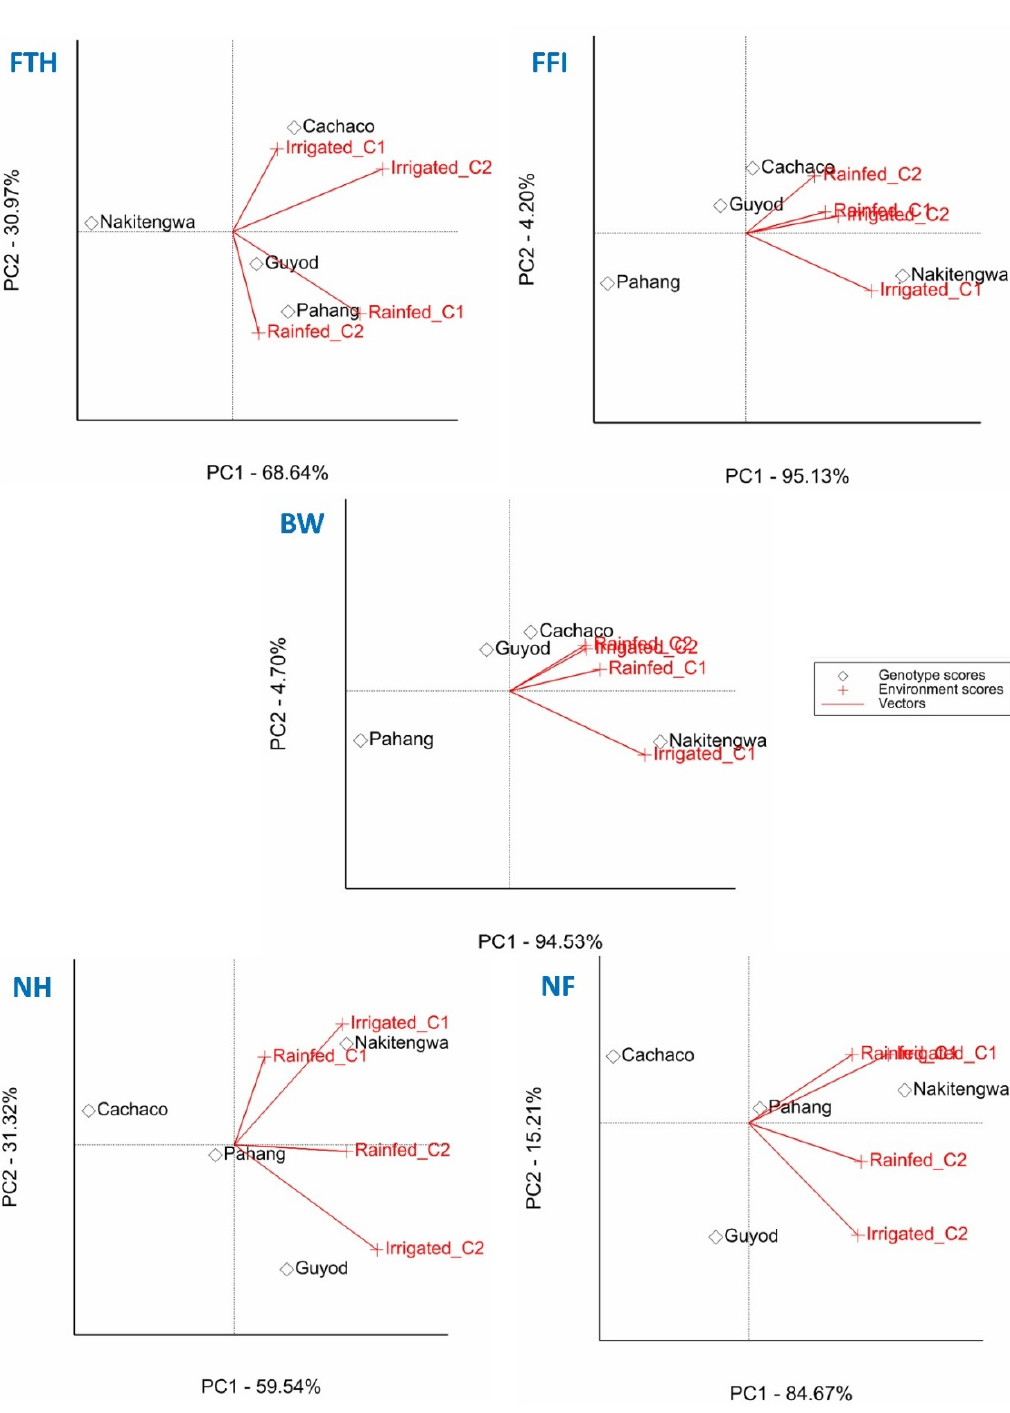
Figure 7. Genotype and genotype by environment interaction (GGE) biplots for maturity and yield-related agronomic traits based on the best linear unbiased estimators (BLUEs) from ANOVA in the four cycle-treatment environment com- binations and the four Musa genotypes. FTH: days from flowering to harvest; FFI: fruit-filling index; BW: bunch weight; NH: number of hands; NF: number of fruits. C1: first crop cycle, C2: second crop cycle; PC1: first principal component, PC2: second principal component.